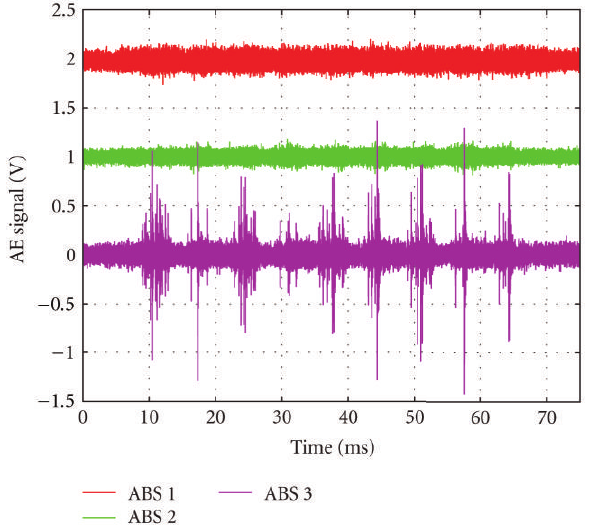
Figure 2: Touchdown signature for the three di ff erent ABS designs (plots o ff set by 1V for